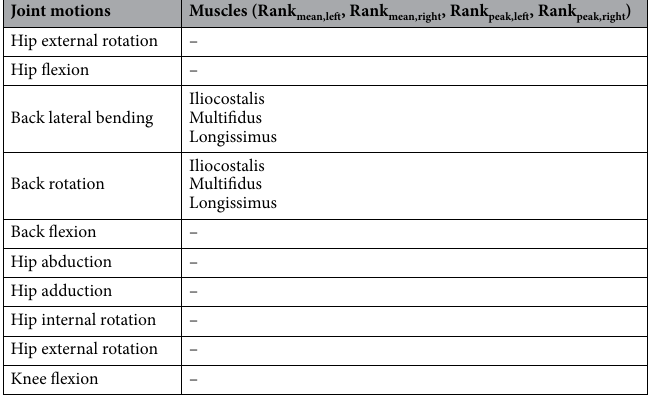
Joint motions Muscles (Rank mean,left , Rank mean,right , Rank peak,left , Rank peak,right